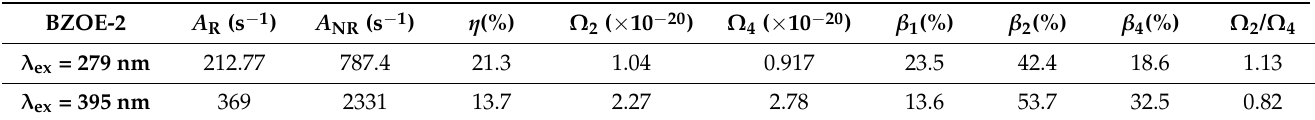
Table 3. Calculated J–O parameters and radiative properties of the BZOE-2 sample ( A R = radiative Rate, A NR = nonradiative rate, Ω n = the Judd − Ofelt parameter, and β n = branching